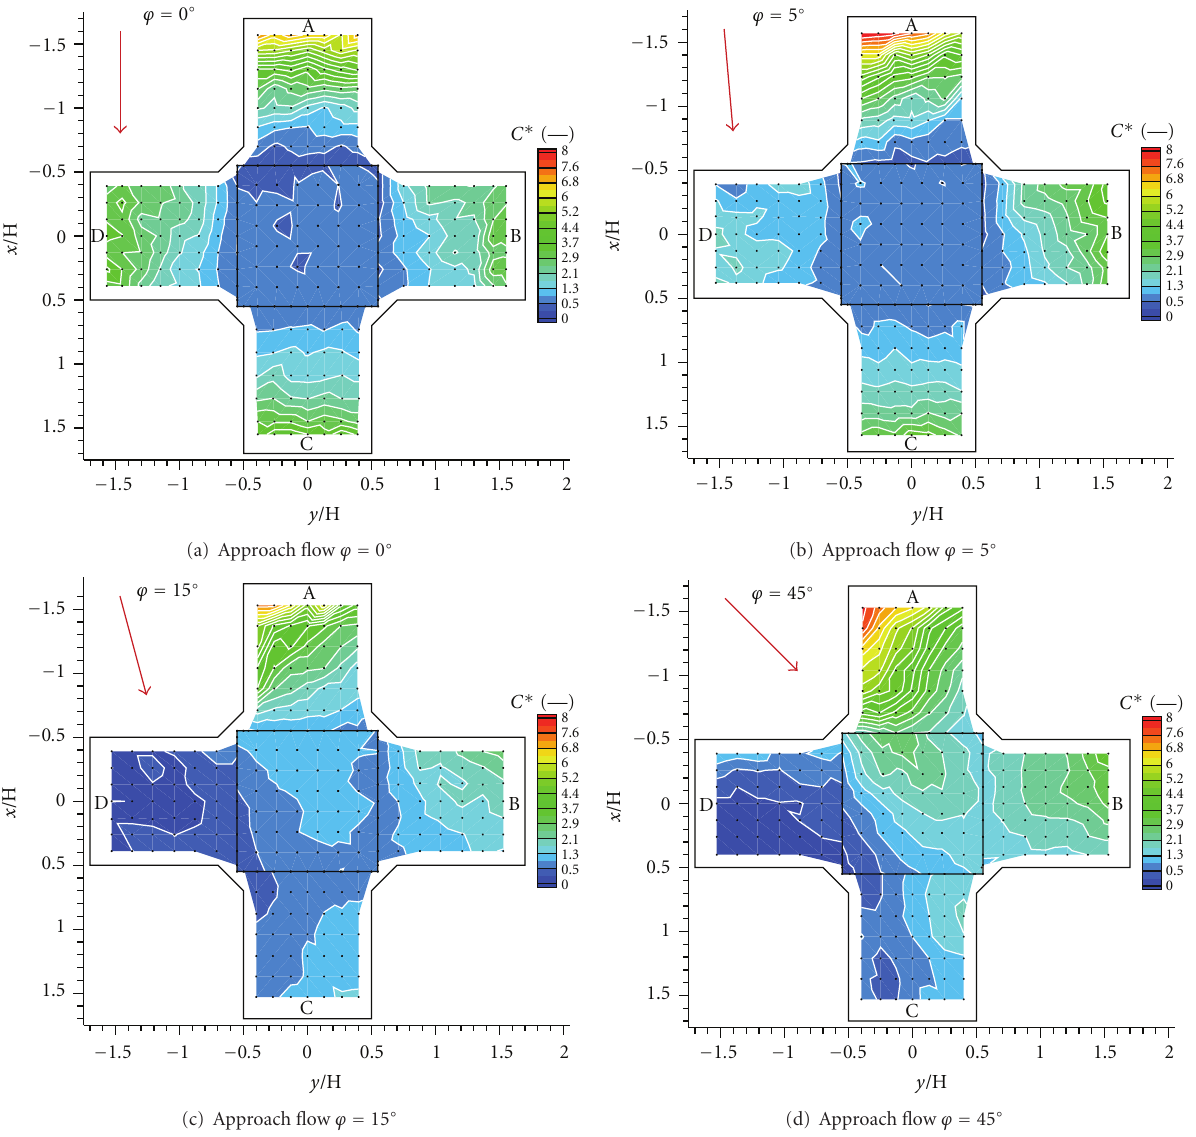
Figure 8: Dimensionless concentration fields for four angles of the approach flow